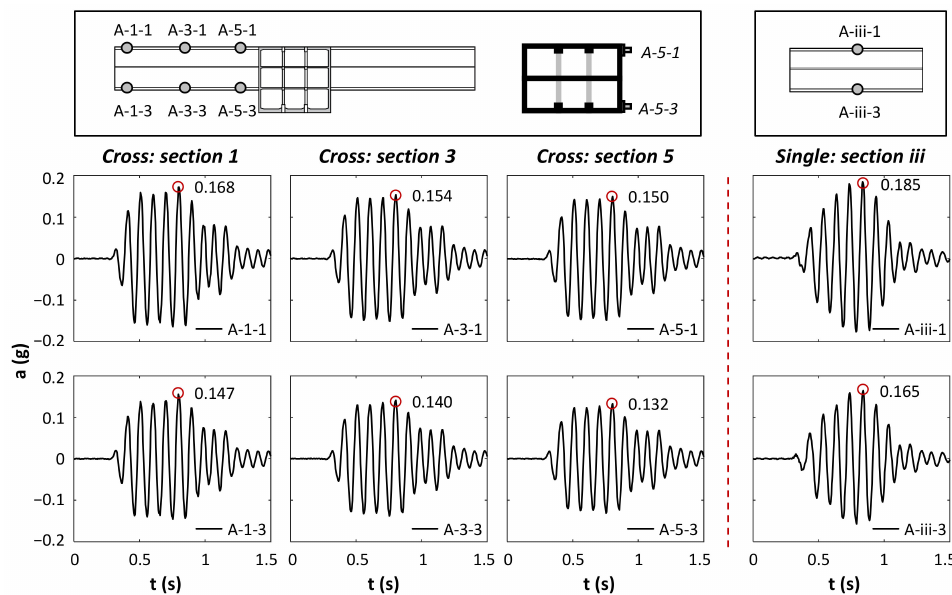
Figure 10. Transverse acceleration response recorded in section iii of the single station and section 1 , section 3 and section 5 of the interchange station during the sinusoidal excitation, with a dominant frequency of 10 Hz. The locations of the accelerometers are also illustrated.